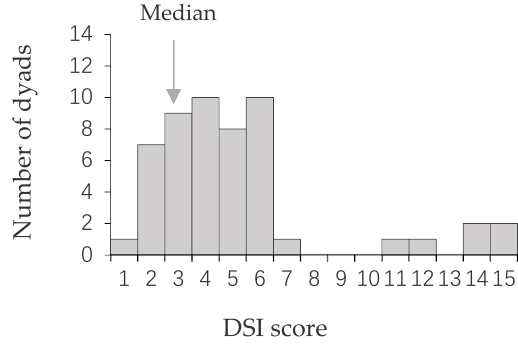
Figure 1. The distribution of male-male DSI scores based on frequency and duration of proximity between all dyads. The DSI indicated the strength of male-male social bonds (mean = 3.8 and median = 3.2).